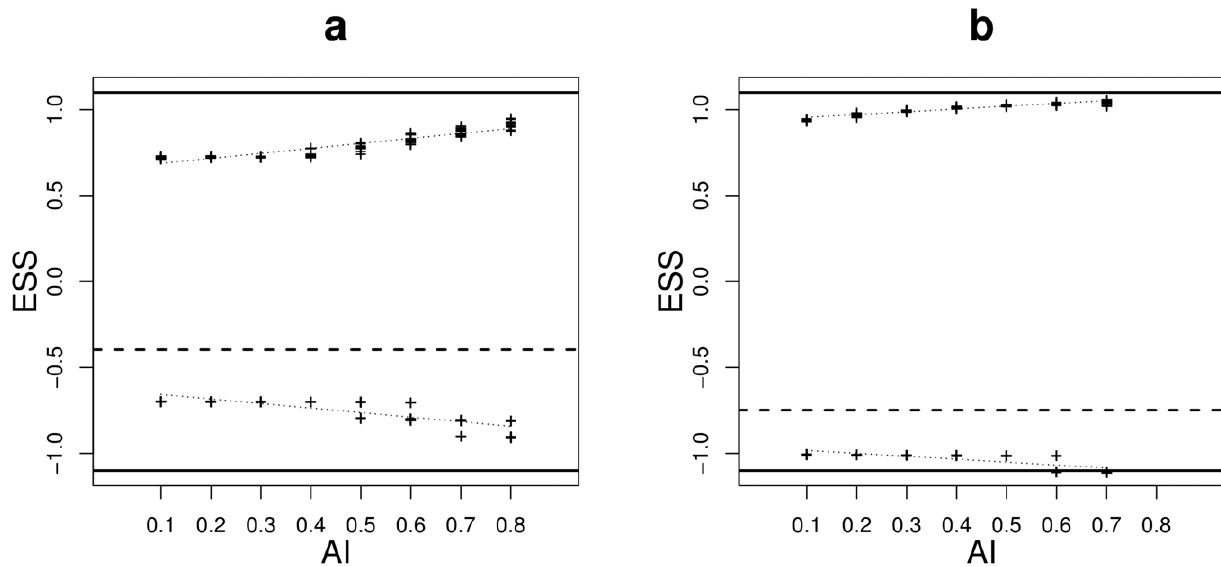
Figure 7. Specialist trait values at the equilibrium (ESS) plotted against the aggregation level of habitat 2 ( AI ) for situation A (a) and situation B (b). The relationship between ESS values and AI was tested by linear regression (dotted line). Dashed line, singular strategy; solid lines, habitat optima. Other parameters are for a: m s ~ 75% , d = s ~ 1 : 1 ( d ~{ b 1 ~ b 2 ~ 1 : 1 and s ~ 1 ) and p ~ 0 : 32 ; for b: m s ~ 15% , d = s ~ 1 : 1 ( d ~{ b 1 ~ b 2 ~ 1 : 1 and s ~ 1 ) and p ~ 0 : 16 . The lattice environment was used.